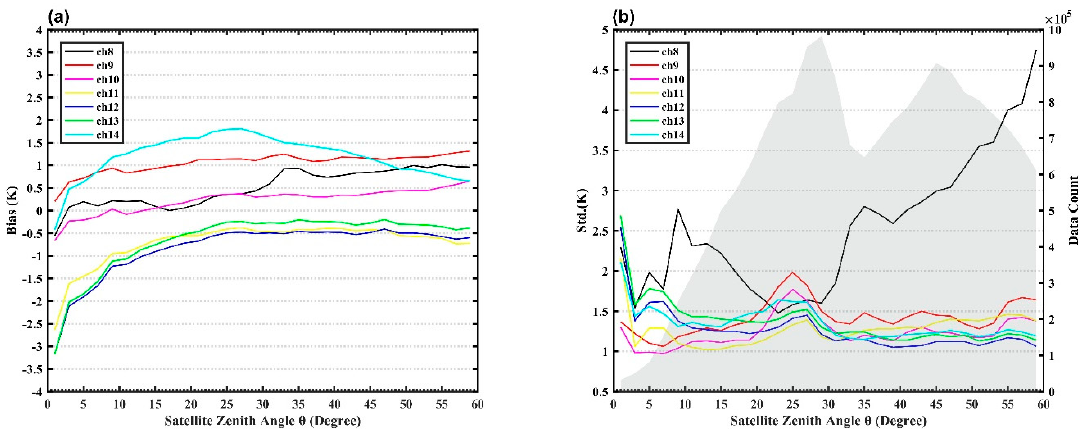
Figure 8. The dependence of ( a ) biases (OMB, unit: K) over the ocean and ( b ) standard deviations on satellite zenith angle 𝜃 (unit: degree) at 2° intervals for AGRI channels 8–14 over the ocean. Observation counts at 2° intervals are shaded gray in ( b ).